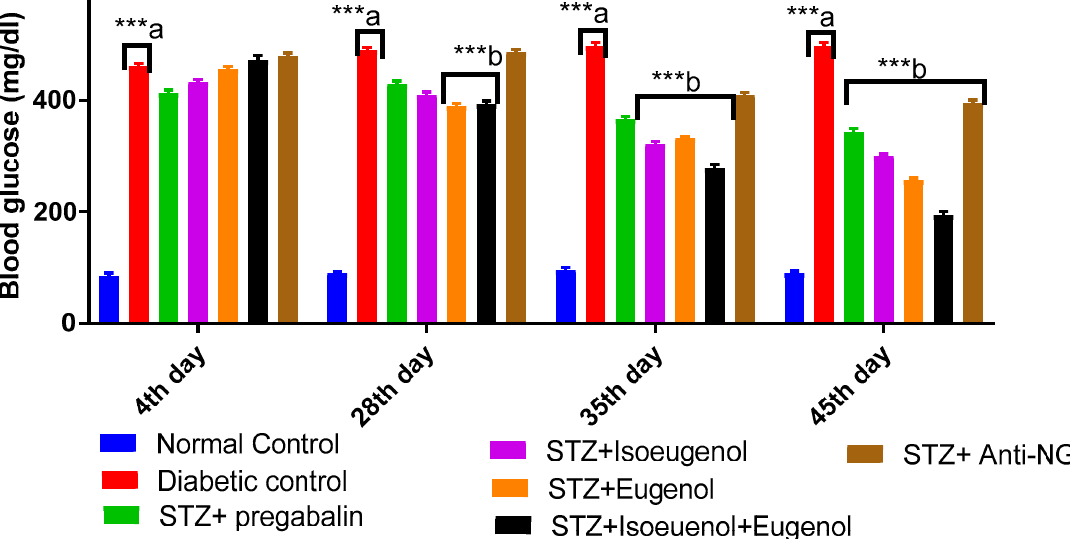
Figure 3. Effect of isoeugenol, eugenol, and their combination on blood glucose level. A p < value of 0.05 was considered statistically significant. Significance is represented as *** p < 0.001; a—normal control versus diabetic control corresponding to the same day, b—diabetic control versus treatment groups corresponding to same day.